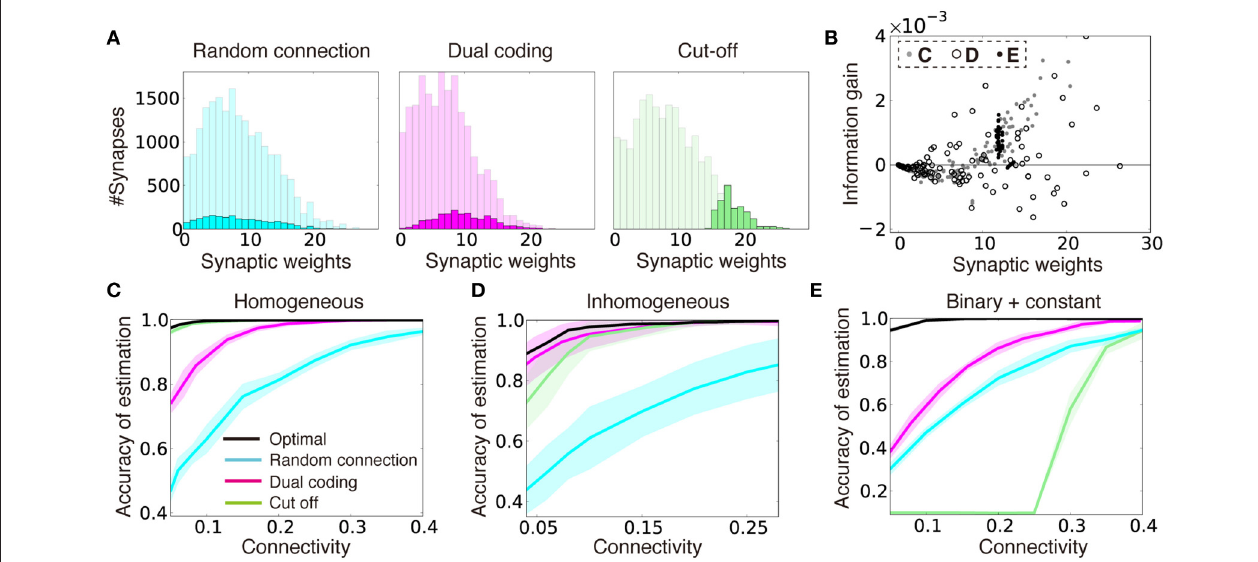
FIGURE 3 | Dual coding yields robust information representation compared to fixed random connections and cut-off strategy. (A) Synaptic weight distributions in random connection (left), dual coding (middle), and cut-off (right) strategies in the model described (C) . Light colors represent possible connections (i.e., normalized distributions of optimal synaptic weights under all-to-all connections), while dark colors show the actual connections chosen under the different strategies. Connection probability was set at ρ 0.1. (B) Relationships between the synaptic weight and the information gain per connection for three input = configurations described in (C–E) . The open black circles were calculated with σ r 2.0 instead of σ r 4.0 for illustration purpose. (C–E) Comparisons of = = performance among different connection structure organizations for models with homogeneous input variability (C) , inhomogeneous input variability (D) , and the model with binary or constant input structures (E) . Note that black lines represent lower bounds for the optimal performance, but not the exact optimal solutions. In (D) , the means and standard deviations were calculated over 100 simulation trials instead of 10 due to intrinsic variability.